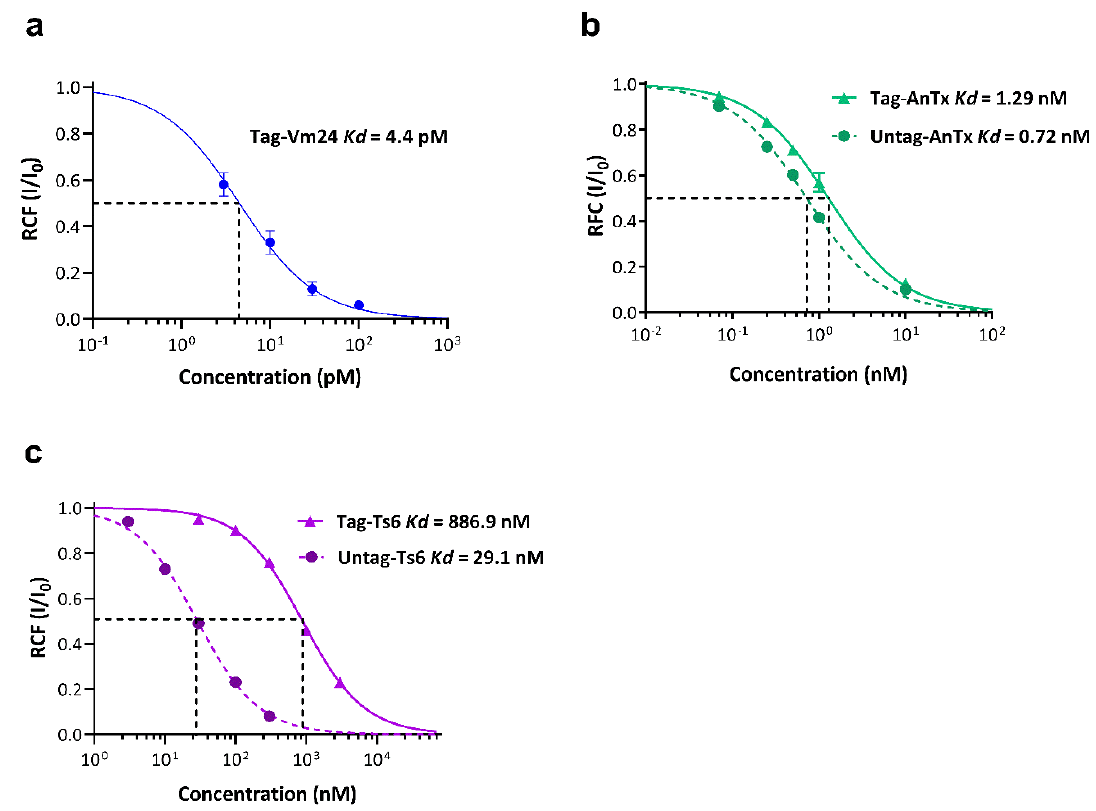
Figure 6. Concentration-dependent block of hKv1.3 by recombinant Vm24, AnTx, and Ts6. A Hill equation (see Materials and Methods for details) was fitted to the averaged remaining current fraction (RCF) values calculated at different toxin concentrations as indicated. The best fit resulted in the Kd values shown at the top of each graph. Hill coefficients were H = 0.92 for Tag-Vm24 (panel ( a )), H = 0.91 for Tag-AnTx, H = 0.95 for Untag-AnTx (panel ( b )), H = 1.06 for Tag-Ts6, and H = 1.03 for Untag-Ts6 (panel ( c )). Solid lines represent tagged peptide, dashed lines represent untagged peptides. Error bar represents SEM and n = 3-5.